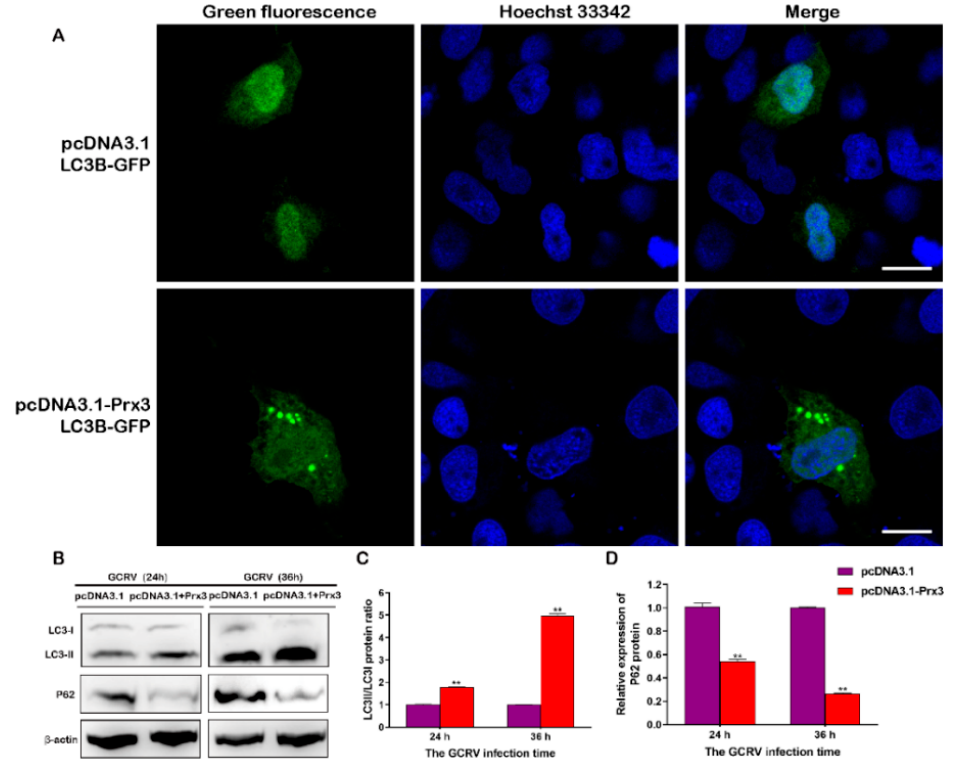
Figure 10. Overexpression of CiPrx3 enhanced autophagy. ( A ) CiPrx3 induced the accumulation of GFP-LC3B puncta in transfected cells. GCO cells were co-transfected with autophagy report plasmids GFP-LC3B and pcDNA3.1- CiPrx3 or pcDNA3.1 for fluorescence observation. Scale bar = 20 µ m. ( B ) CiPrx3 enhanced autophagy after GCRV infection. GCO cells were transfected with pcDNA3.1 or pcDNA3.1- CiPrx3 and then infected with GCRV; cells were harvested at different time points post-infection and protein expression levels of LC3-II/LC3-I and P62 were detected by Western blotting. ( C , D ) The calculated protein expression levels of LC3-II/LC3-I ( C ) and P62 ( D ) at different time points post GCRV infection. Data were shown as the mean ± SD ( n = 3). Asterisks represent significant differences (** = p ≤ 0.01).